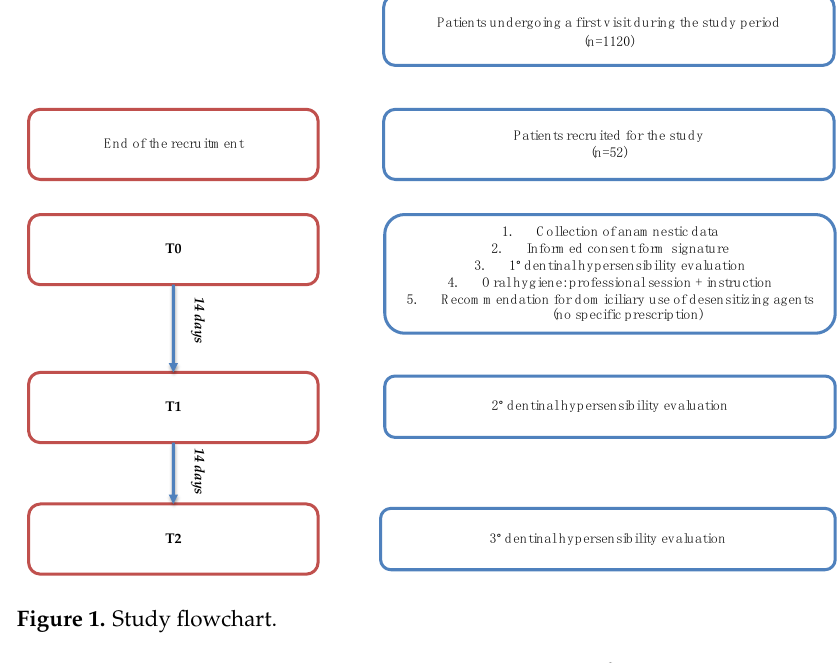
Figure 1. Study flowchart.